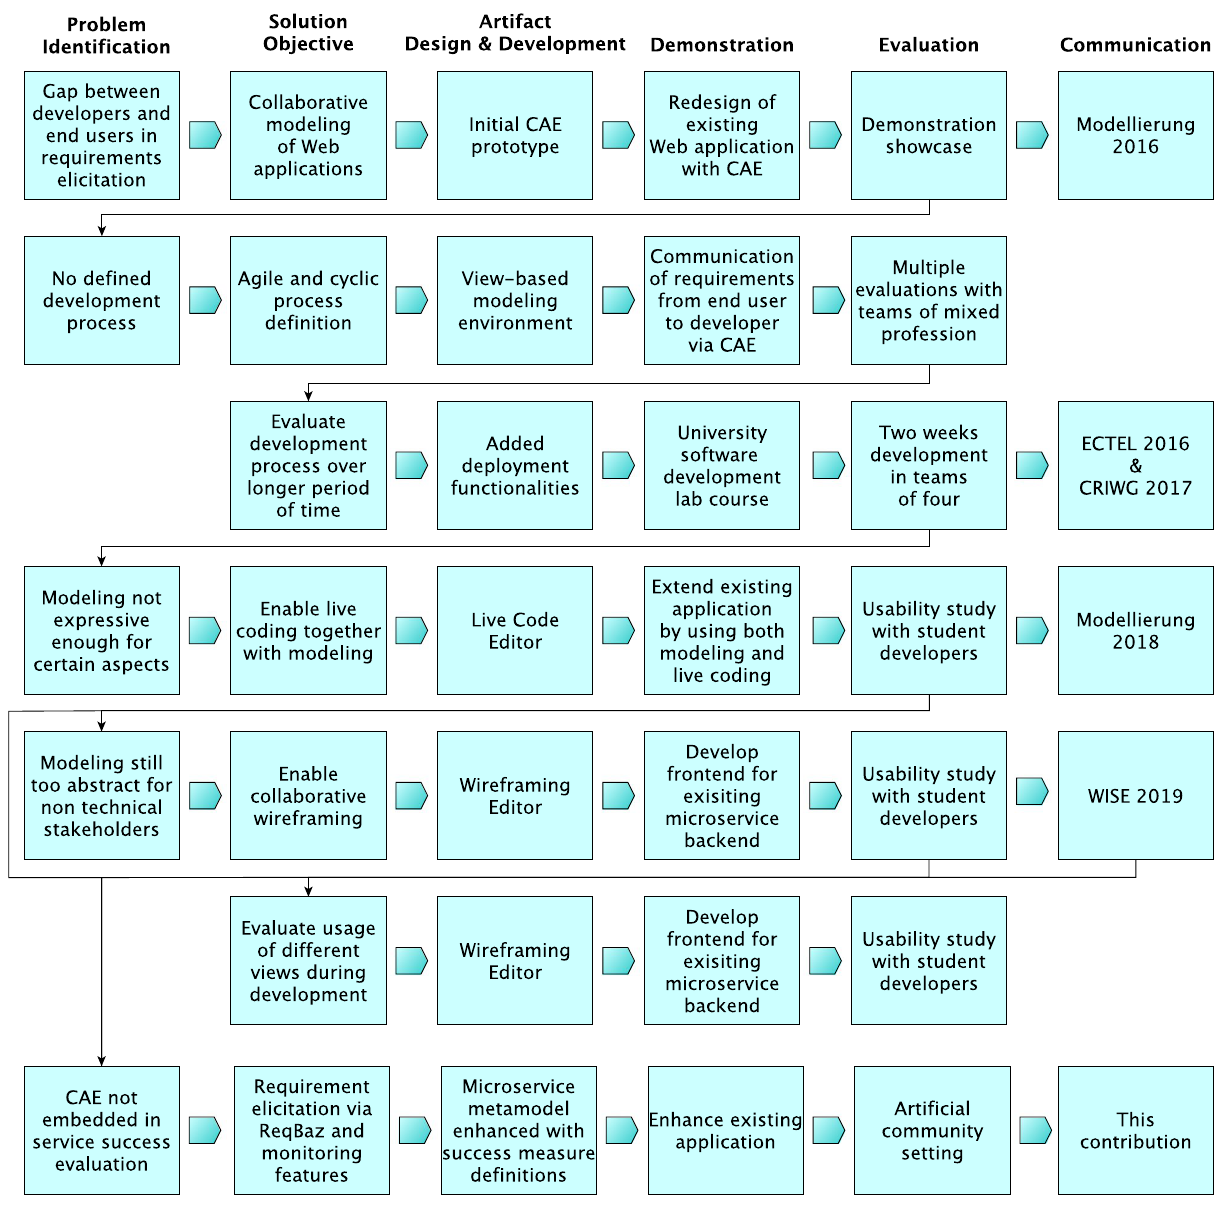
Fig. 1 Design science methodology we followed in conducting this